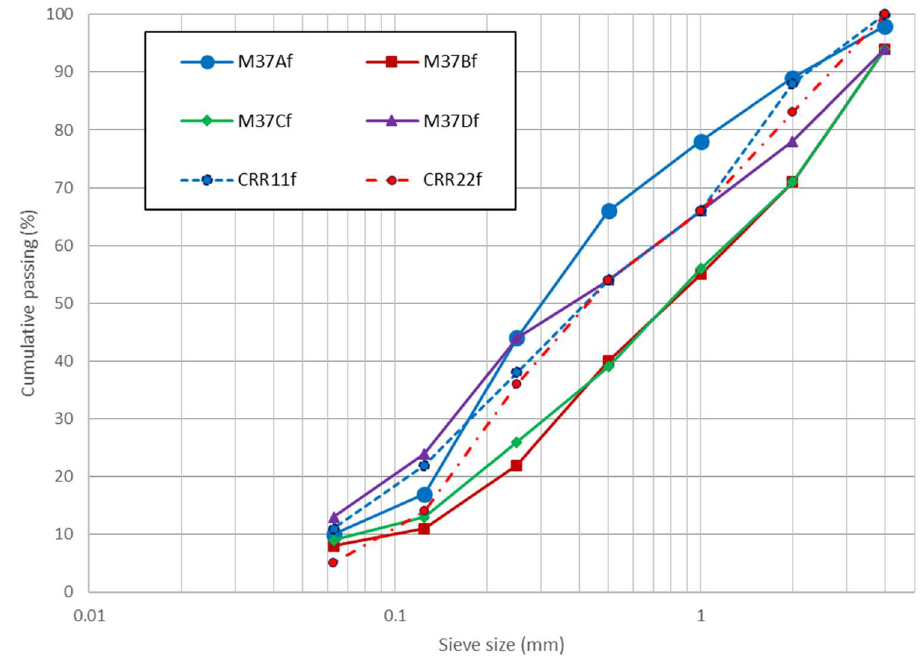
Figure 4. Particle size distribution of the sable fractions of the studied samples.